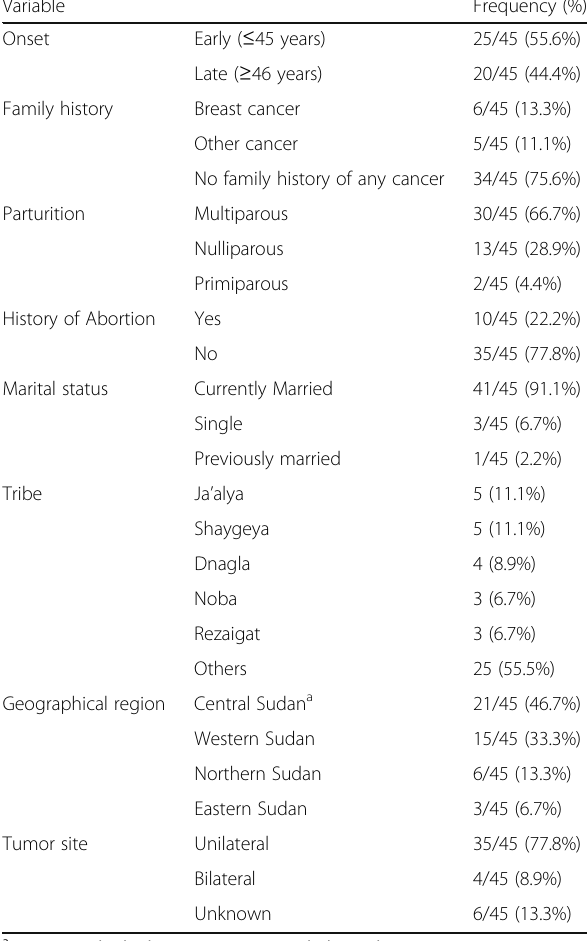
Table 2 Patients demographic and characteristics Variable